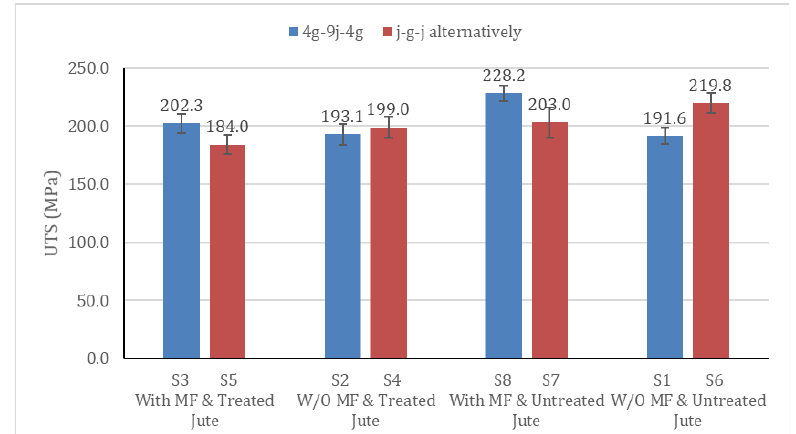
Figure 6: Average tensile strength comparisons of fabricated hybrid composite panels.